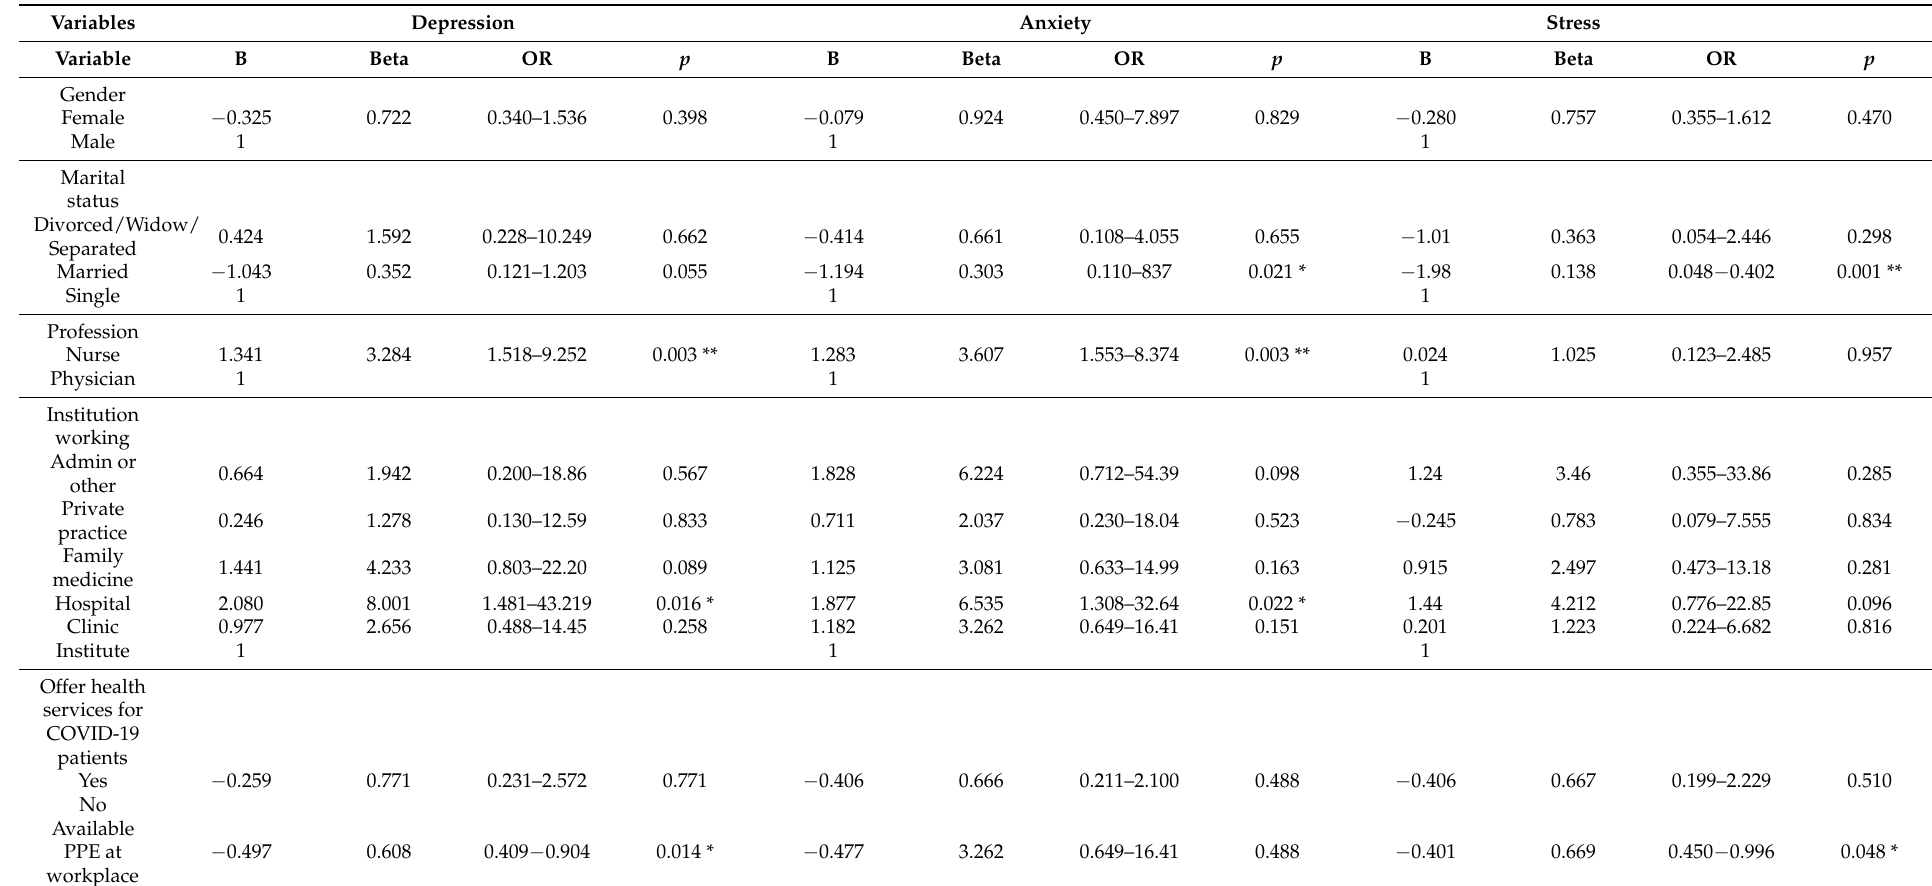
Table 5. Linear modeling analysis for predicting depression, anxiety, and stress scores ( n =